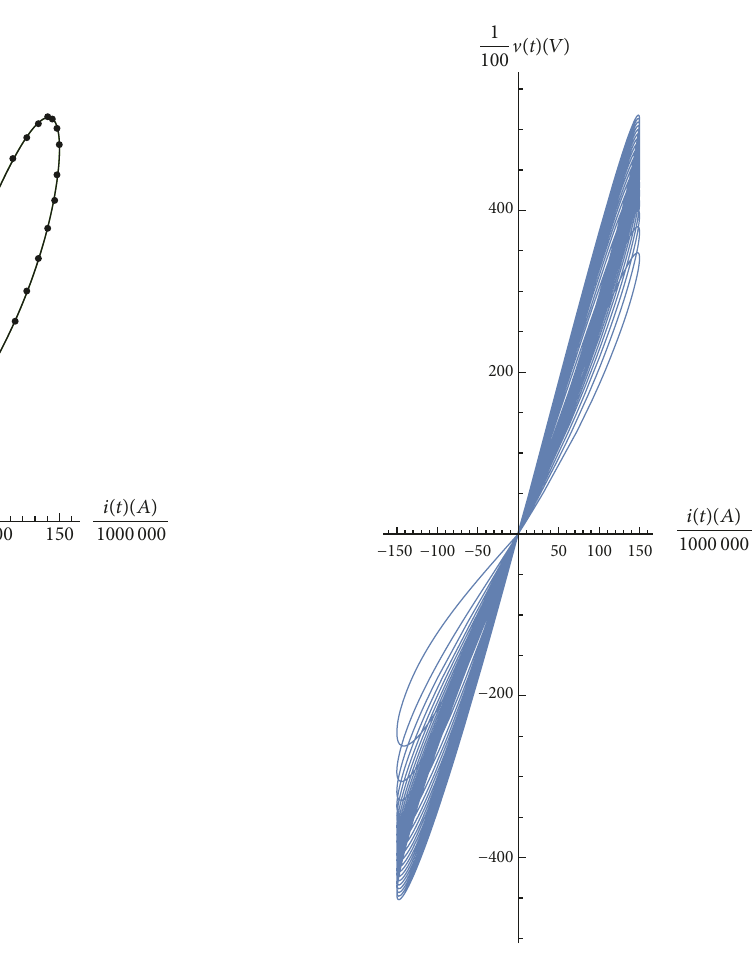
Figure 13: V (𝑡) - 𝑖(𝑡) of the fractional order memristor: 𝛼 = 1.25 and 𝐼